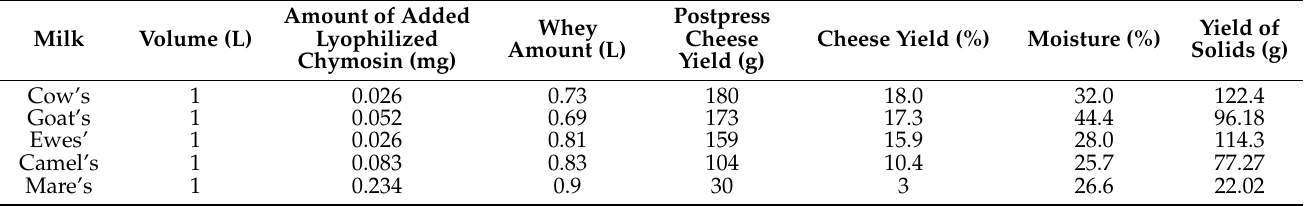
Table 4. A comparison of parameters of cheese production with the lyophilized BacChym from cow’s, goat’s, ewes’, camel’s and mare’s